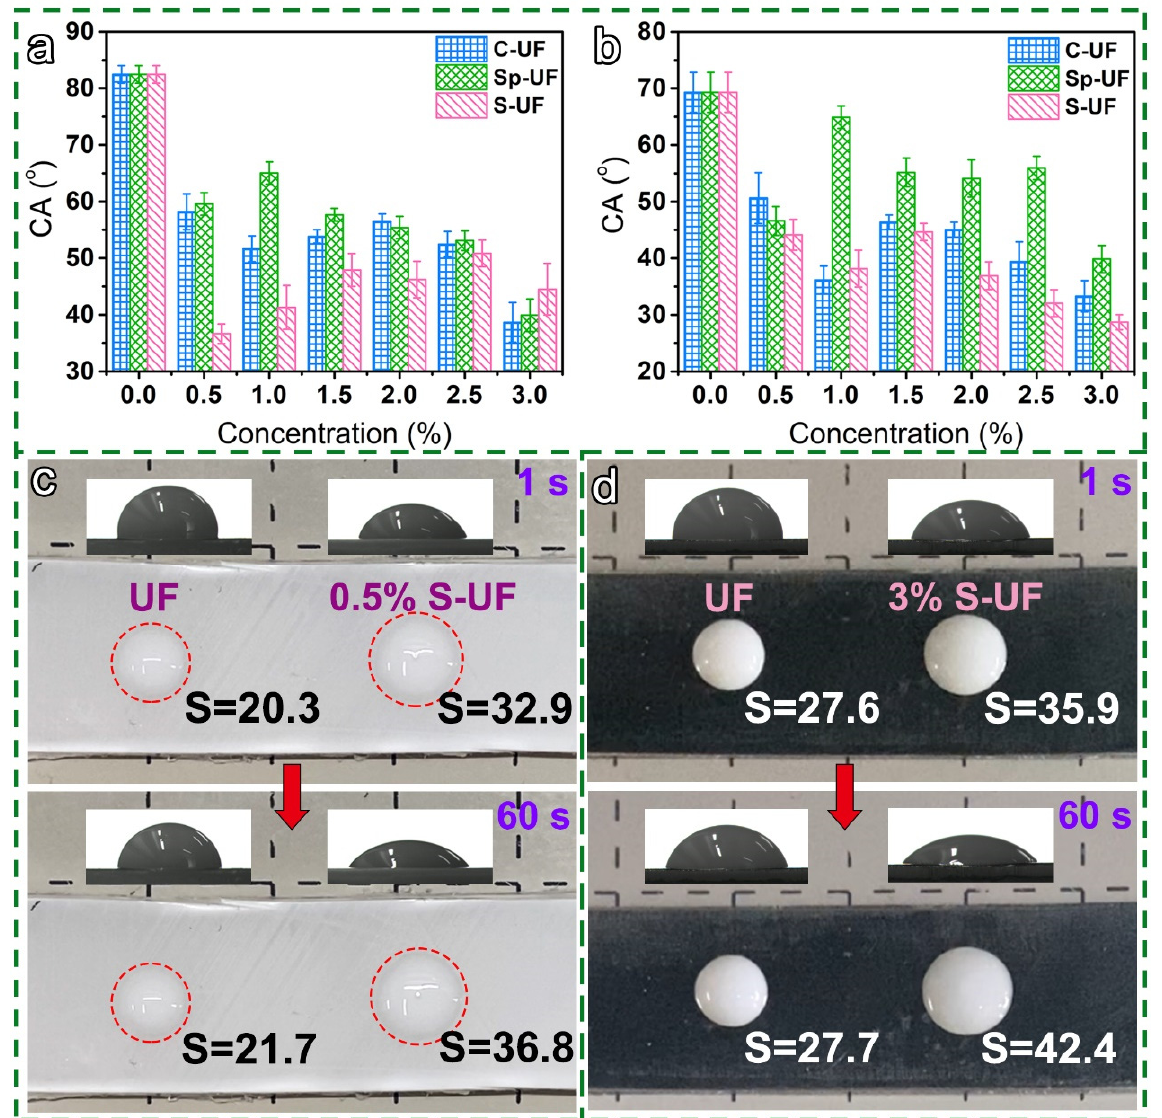
Figure 9. The CA curves of the UF and reconfigured UF resins on the surface of ( a ) PP board, and ( b ) tinplate. Optical photos and corresponding CA images of UF and reconfigured UF resins in contact with the surface of ( c ) PP board and ( d ) tinplate for 1 s and 60 s.